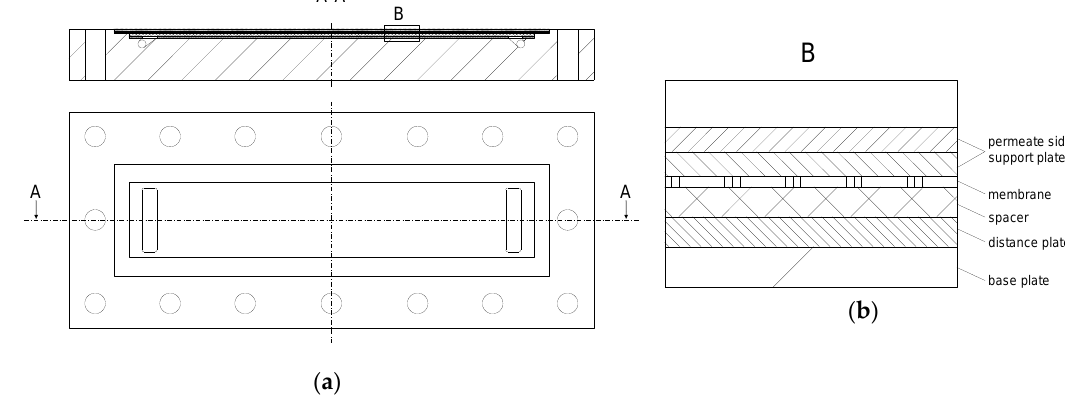
Figure 2. Filtration plant equipped with the filtration unit.